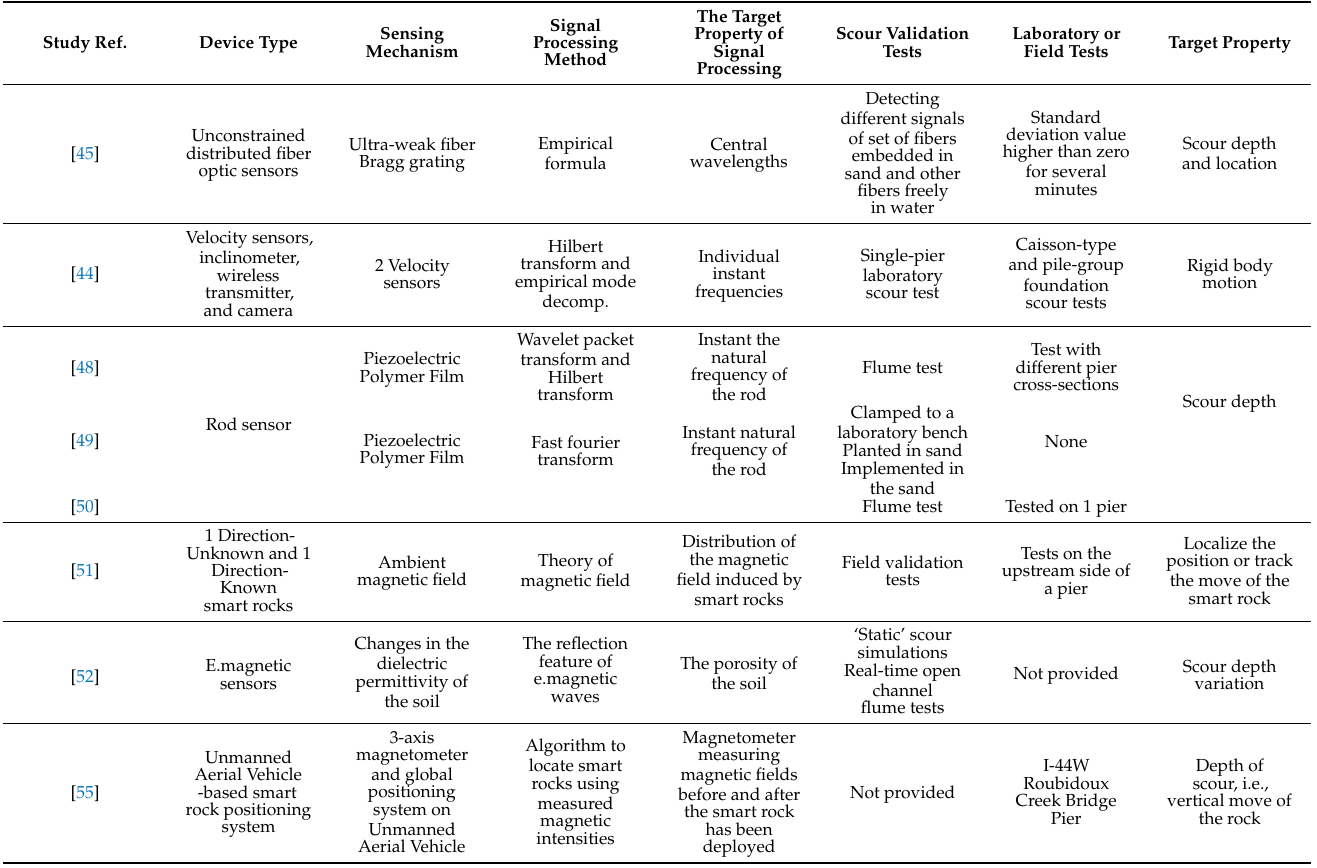
Table 2. Properties of devices used in direct monitoring